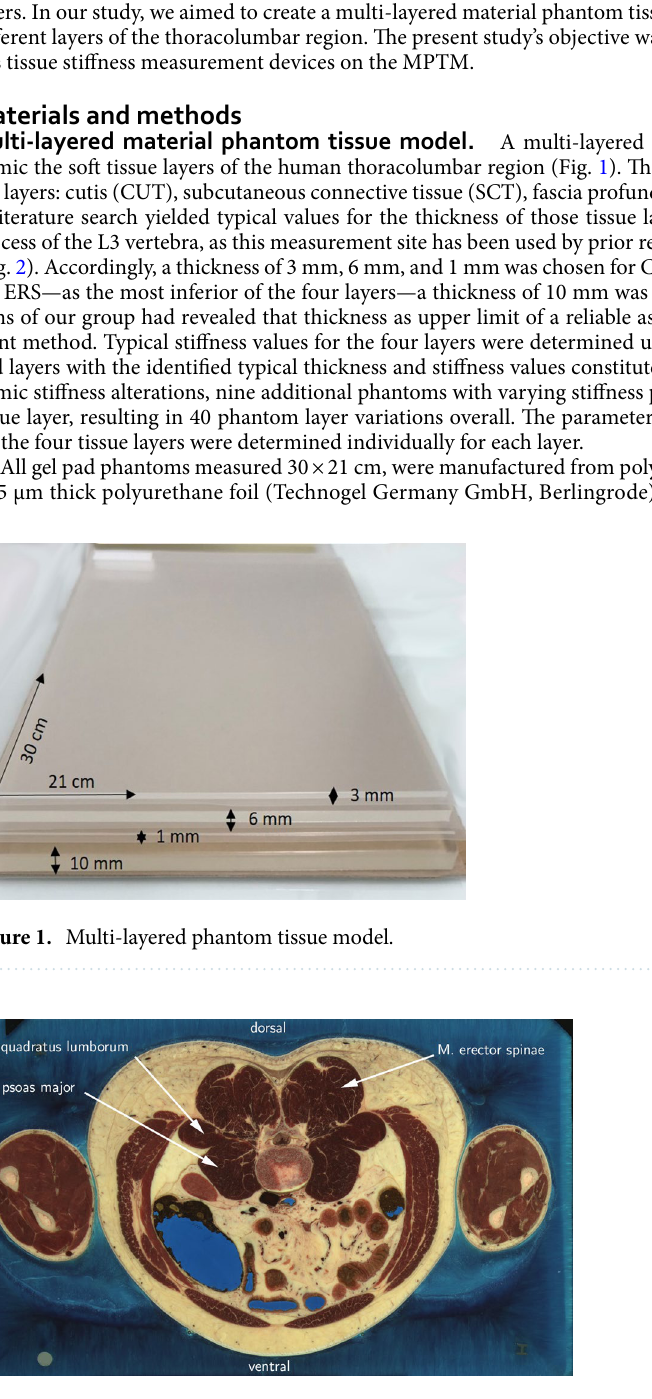
Figure 2. Cross-section of L3 region. Photo: Modified from Visible Human Project of U.S. National Library of Medicine 23 , accessed through NPAC/OLDA Visible Human Viewer 24 with